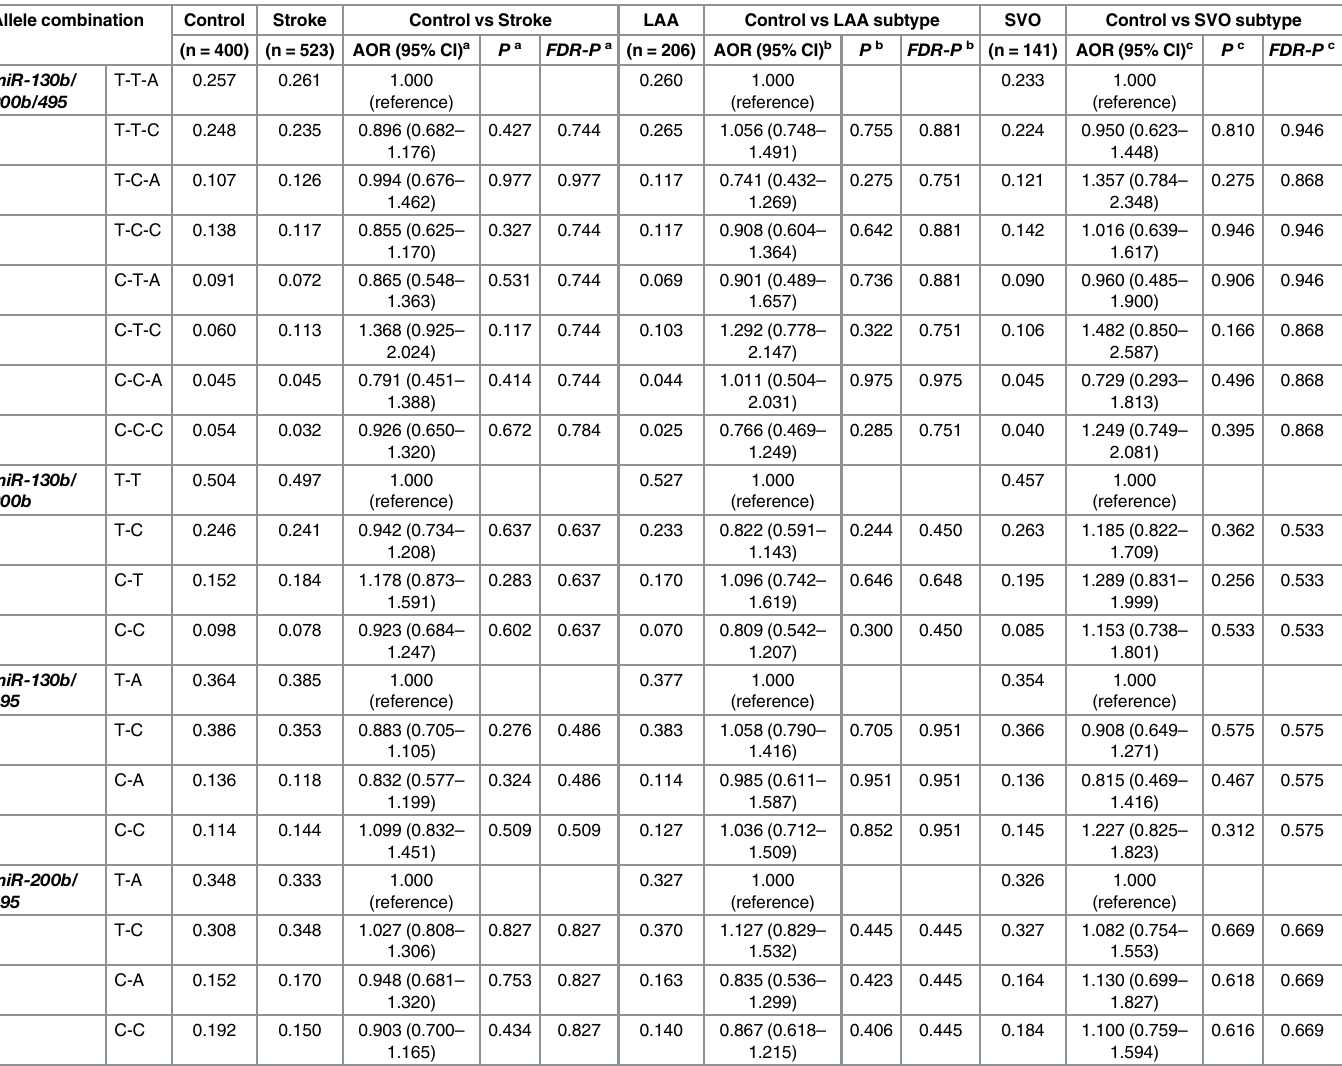
Table 4. Allele combination analysis of microRNA polymorphisms in ischemic stroke patients and controls. Allele